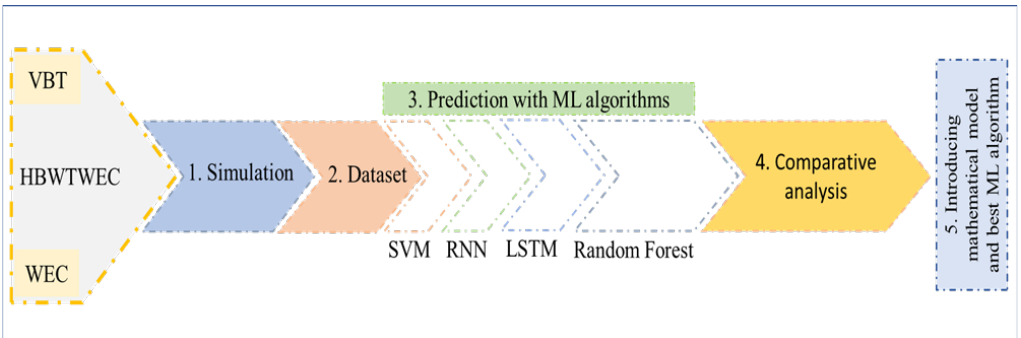
Figure 1. Overview of the proposed study.